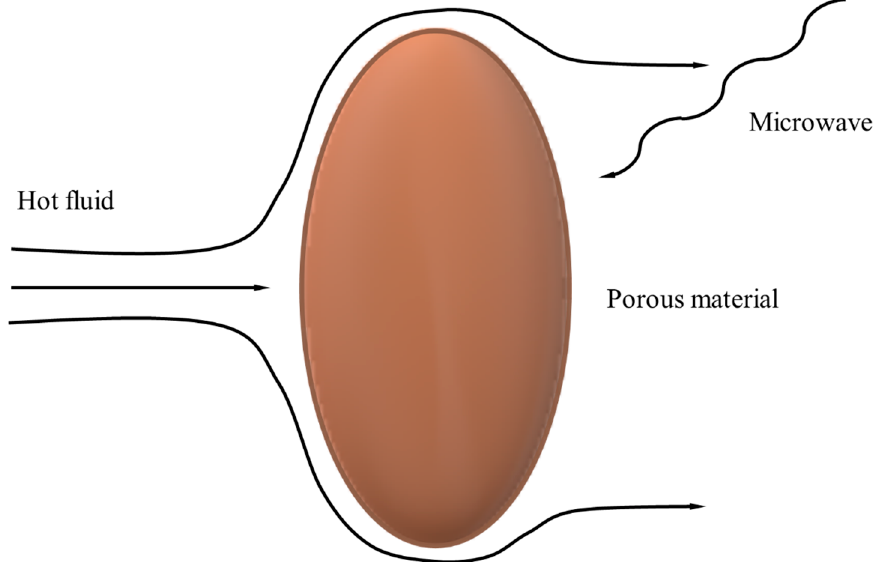
Figure 1. The physical problem studied in this work.